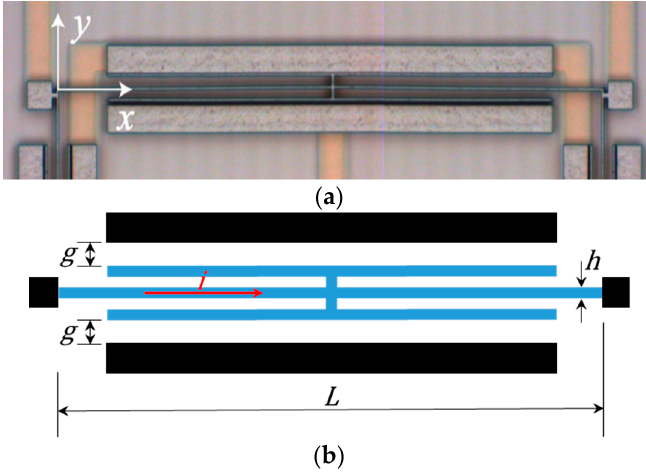
Figure 1. ( a ) SEM picture of a movable structure of the resonant MEMS magnetometer [19], and ( b ) scheme of the structure with the notation adopted.